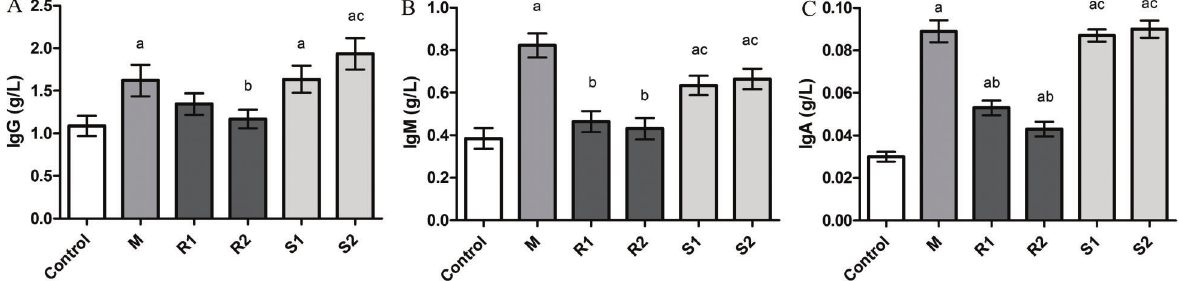
Figure 3. Levels of C3 ( A ) and C4 ( B ). M: intestinal obstruction group; R1: 2-day natural recovery group; R2: 4-day natural recovery group; S1: 2-day Sijunzi treated group; S2: 4- day Sijunzi treated group. Data are reported as means ± SD. a P o 0.05 compared to normal con- trol group; b P o 0.05 compared to M; c P o 0.05 compared to R1 and R2 (ANOVA).